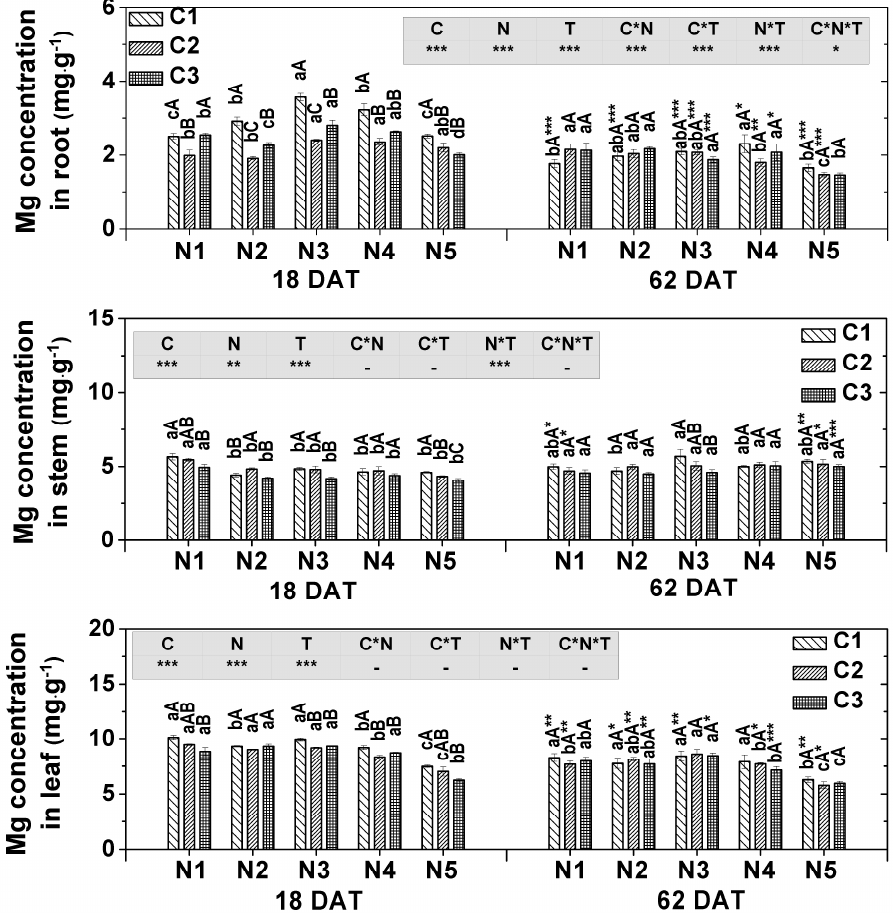
Figure 6. Magnesium concentrations in different tissues of cucumber plants grown under different N and [CO 2 ] levels at two growth stages ( n = 6). Bars represent standard errors. CO 2 levels: C1, C2, and C3: 400, 625, and 1200 μ mol mol − 1 . N levels: N1, N2, N3, N4, and N5: 2, 4, 7, 14, and 21 mmol L − 1 .